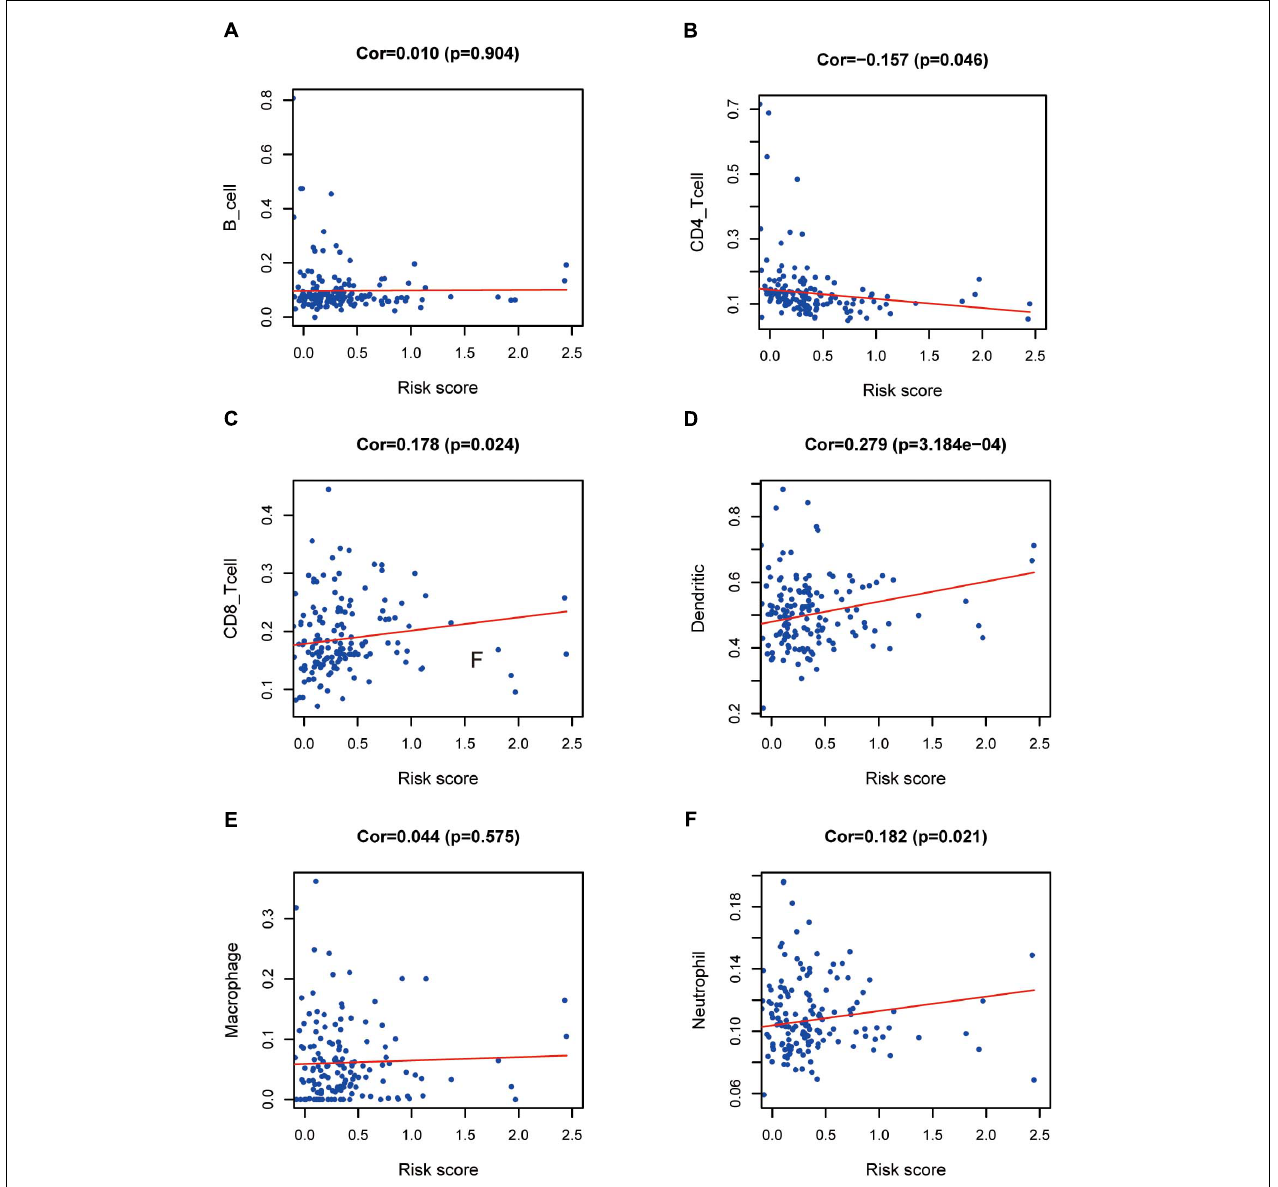
FIGURE 9 | Relationships between prognostic value and degree of infiltration of six types of immune cells. The relationship of the eight-IRG prognostic model with (A) B cells, (B) CD4 T cells, (C) CD8 T cells, (D) dendritic cells, (E) macrophages, and (F) neutrophils is revealed by scatter